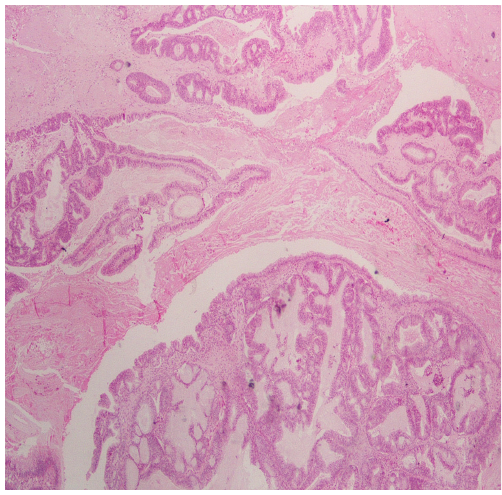
Figure 1: Microphotograph from a section of the endometrial tu- mor (endometrioid type carcinoma) (H&E × 250).